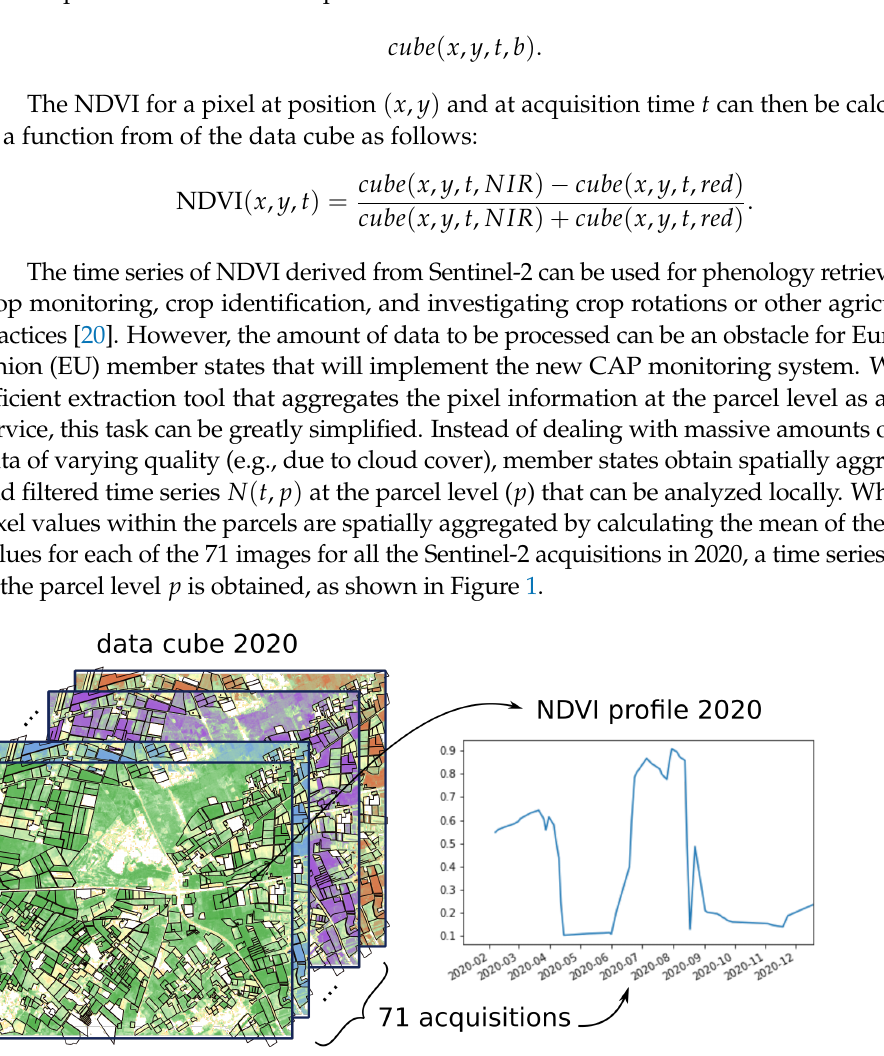
Figure 1. Mean value from the normalized difference vegetation index (NDVI) pixel values that cover a single parcel. The NDVI values are extracted from a data cube that represents 71 Sentinel-2 acquisitions in